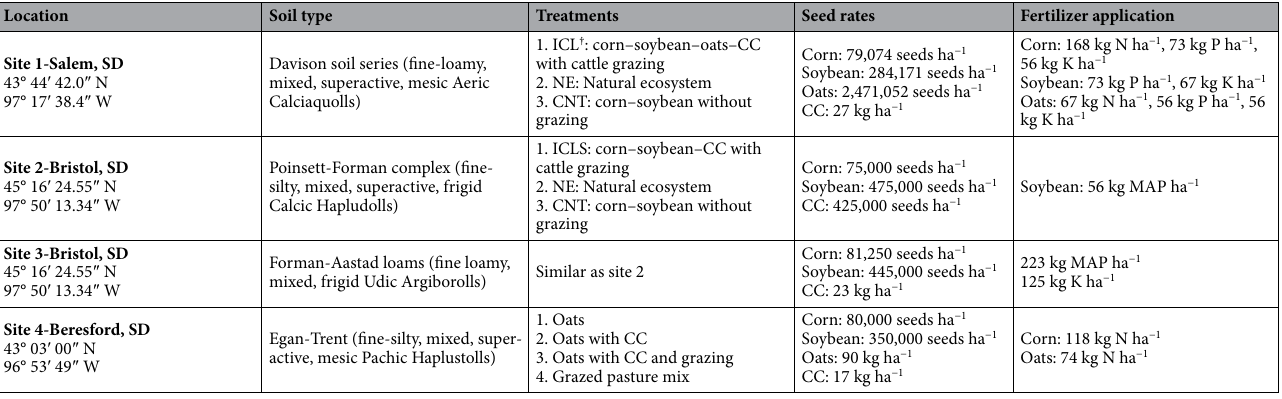
Table 5. Detailed description of soil type, treatments, and management for the study sites. CC is a mixture of grasses, legumes, and brassicas: pea, sorghum, radish, lentil, cowpea, turnip, and oats. † ICL integrated crop– livestock, NE natural ecosystem, CNT control, CC cover crop, g